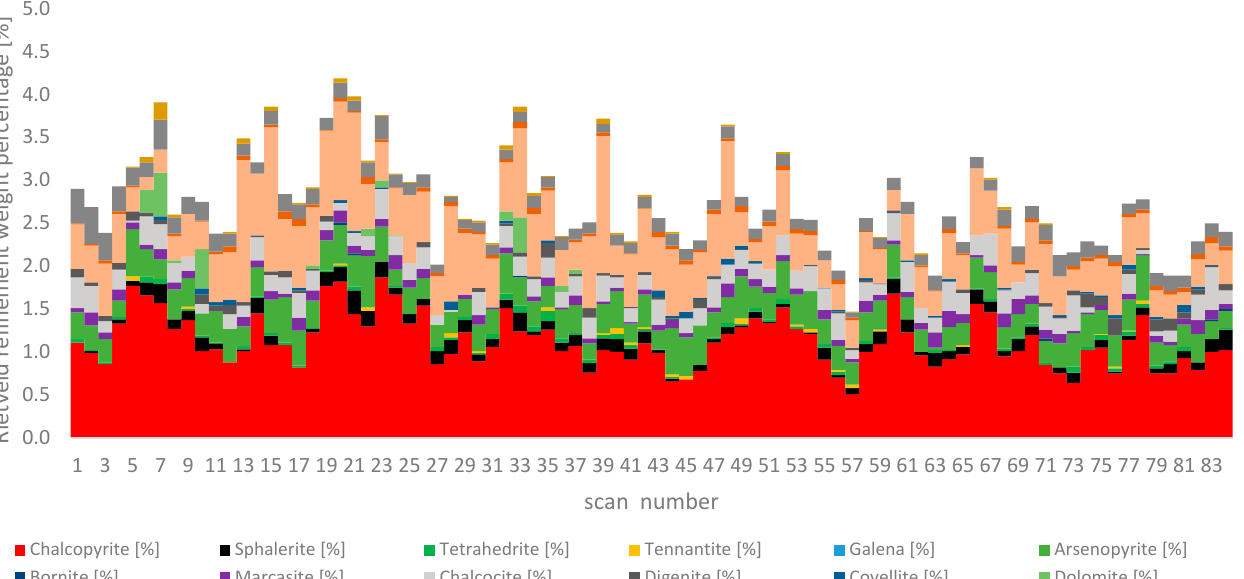
Figure 5. Mineralogical variability of ore blends for the major gangue minerals as determined by XRD and Rietveld re- finement.